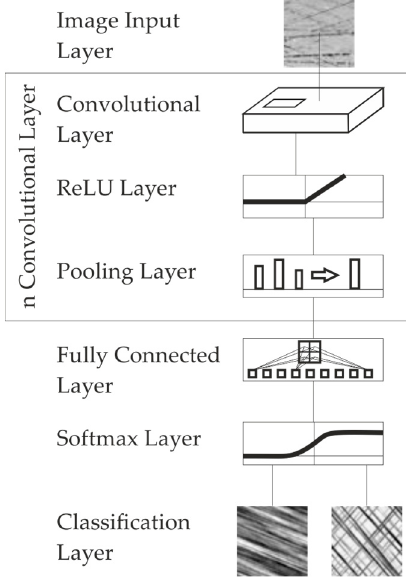
Figure 6. Architecture of the considered Convolutional Neural Networks (CNNs).